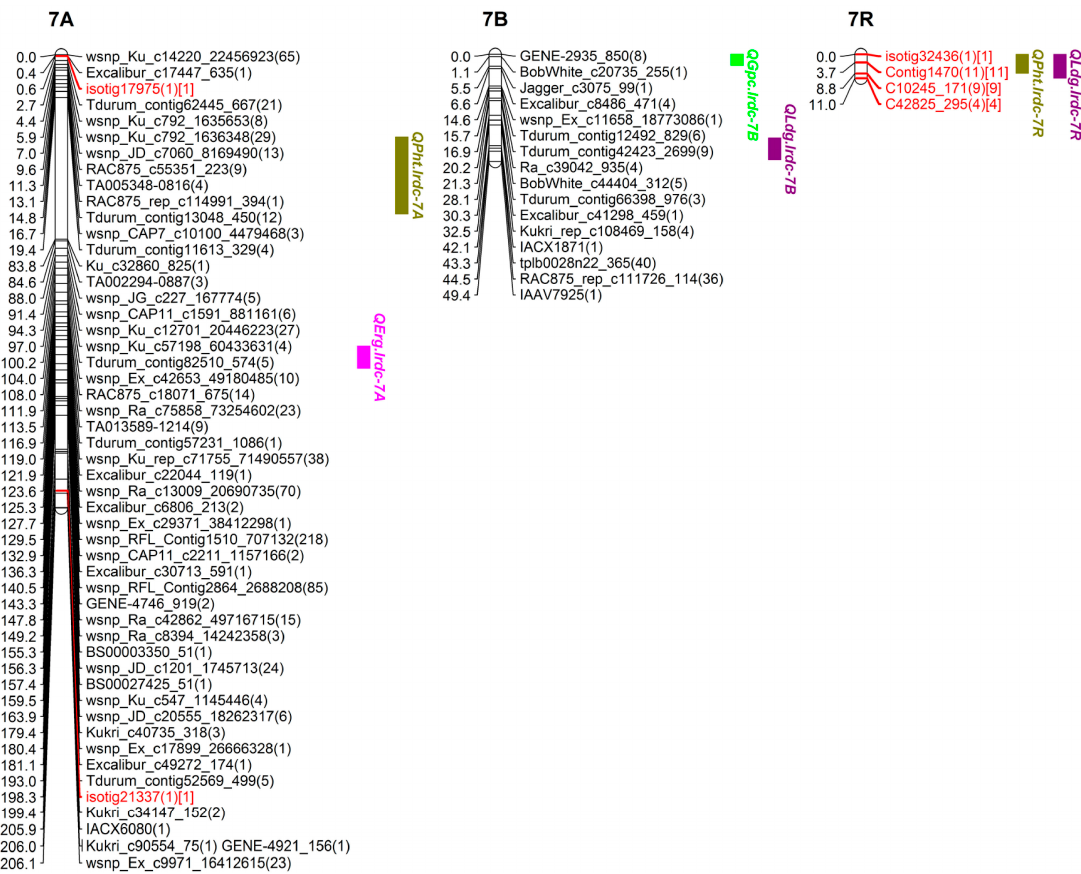
Figure 7. Homoeologous group 7 SNP map of TMP16315/AC Ultima triticale DH population. Loci on chromosome maps are represented by unique markers. Marker names in black and red colors represent genomic regions largely dominated by SNPs derived from wheat genomes A/B/D and rye genome R, respectively. Numbers in round brackets represents total number of SNPs at the locus and number in square brackets represents SNPs derived from R genome. The QTL for different traits are given on the right side of maps.